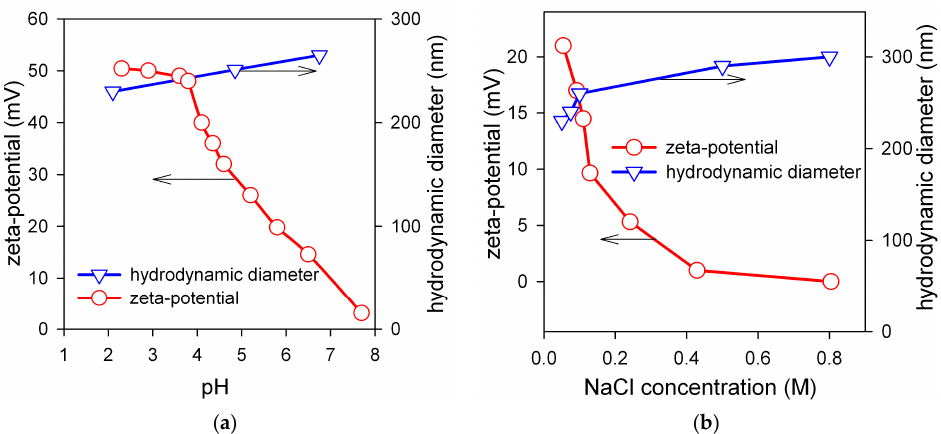
Figure 5. ( a )—pH dependence of the zeta-potential and of the mean hydrodynamic diameter of aggregates in the suspension FF2 of the encapsulated iron oxide MNPs. ( b )—Dependence of the zeta-potential and of the mean hydrodynamic diameter of aggregates in the FF2 suspension of the encapsulated MNPs at pH = 6.5.